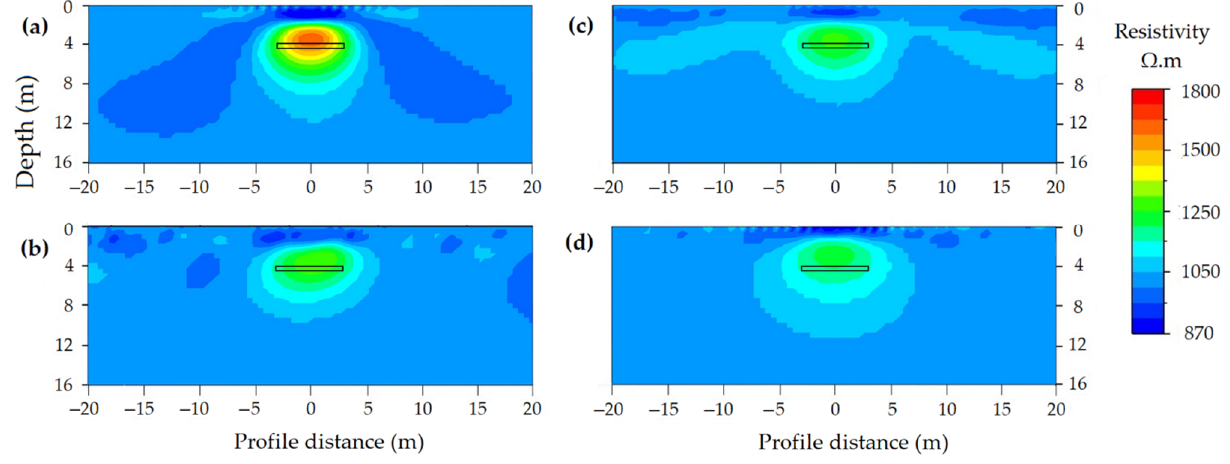
Figure 13. The inverted resistivity model for scenario 1 with 0.5 × 6 m cavity size using: ( a ) DD array, ( b ) PD array, ( c ) WS array, ( d ) PP array. The rectangular box indicates the actual cavity target.